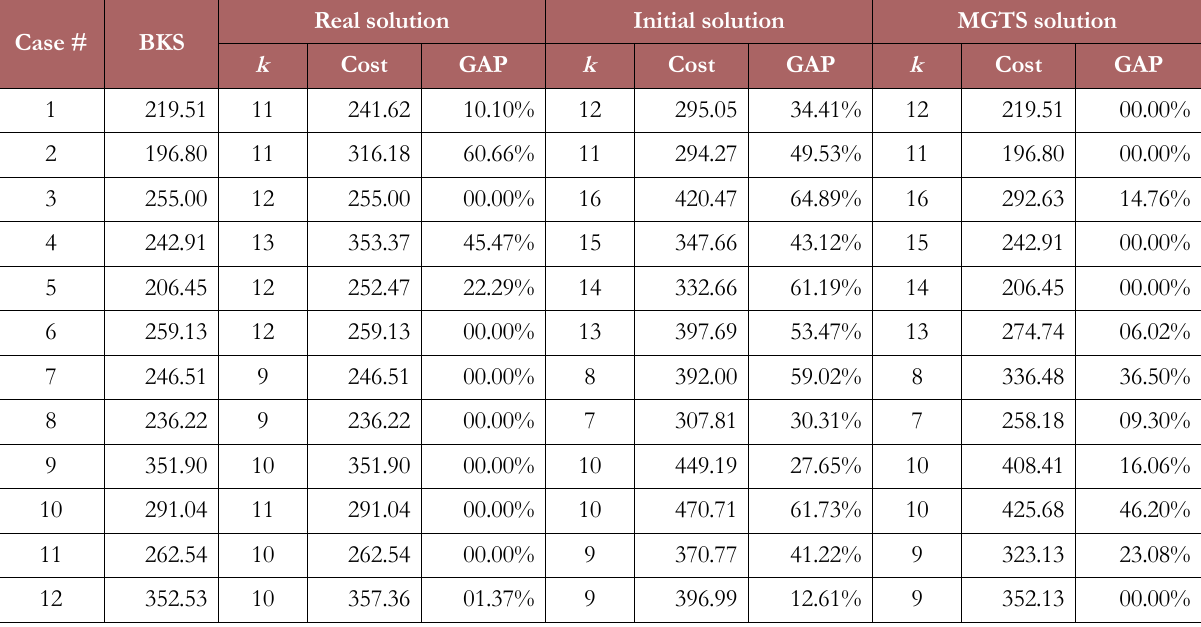
Table 3. Comparison between the current solution applied by the company and the proposed